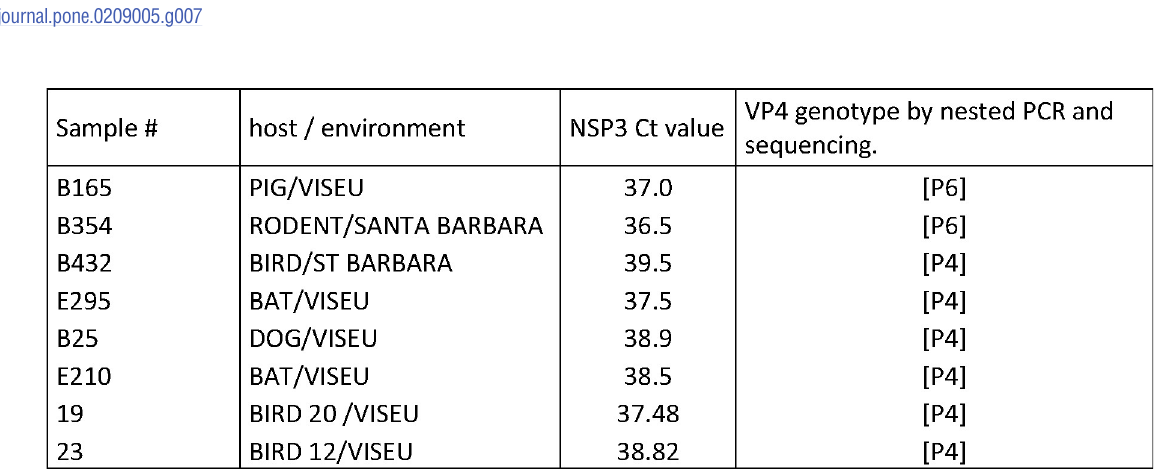
Fig 8. Results of nested and qRT-PCR for samples characterized in accordance to the host and localization.